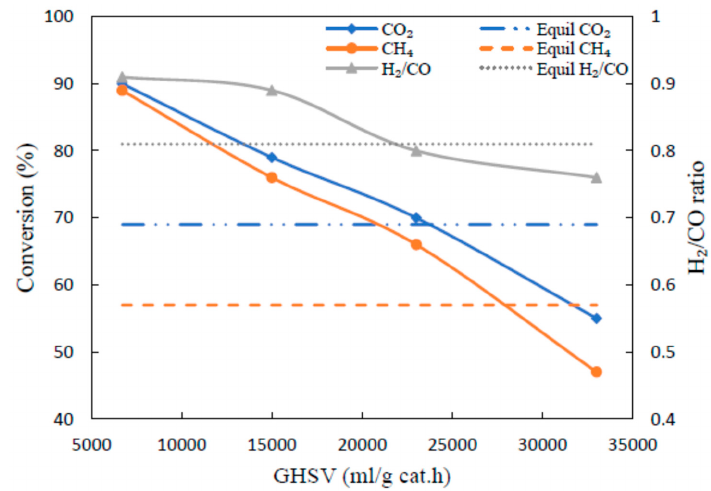
Figure 5. Effect of GHSV on Ni/MgO/AC catalyst performance for dry reforming of methane at 650